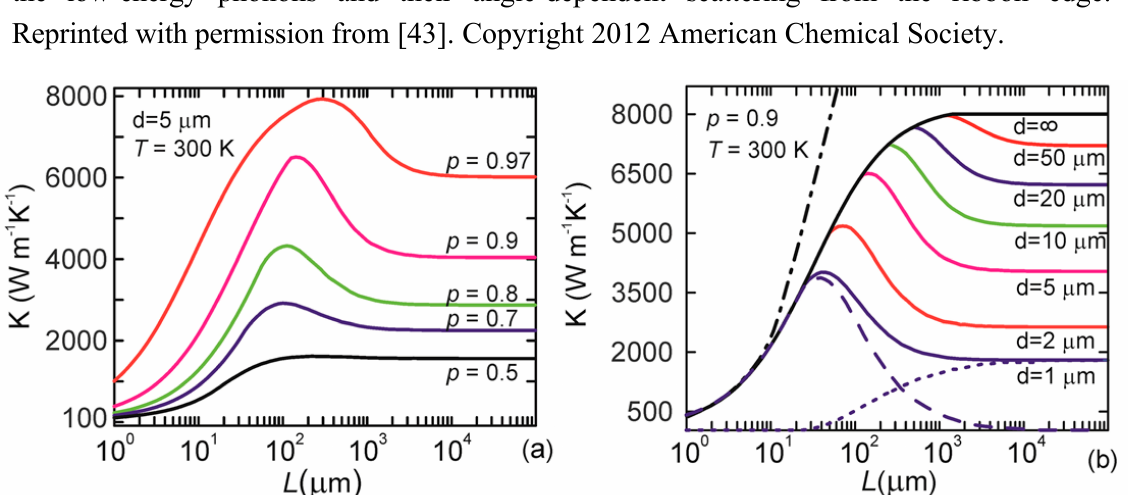
Figure 2. ( a ) Dependence of the thermal conductivity of the rectangular graphene ribbon on the ribbon length L shown for different specular parameters p . The ribbon width is fixed at d = 5 µm; ( b ) Dependence of the thermal conductivity of the rectangular graphene ribbon on the ribbon length L shown for different ribbon width d . The specular parameter is fixed at p = 0.9. Note in both panels an unusual non-monotonic length dependence of the thermal conductivity, which results from the exceptionally long phonon mean free path of the low-energy phonons and their angle-dependent scattering from the ribbon